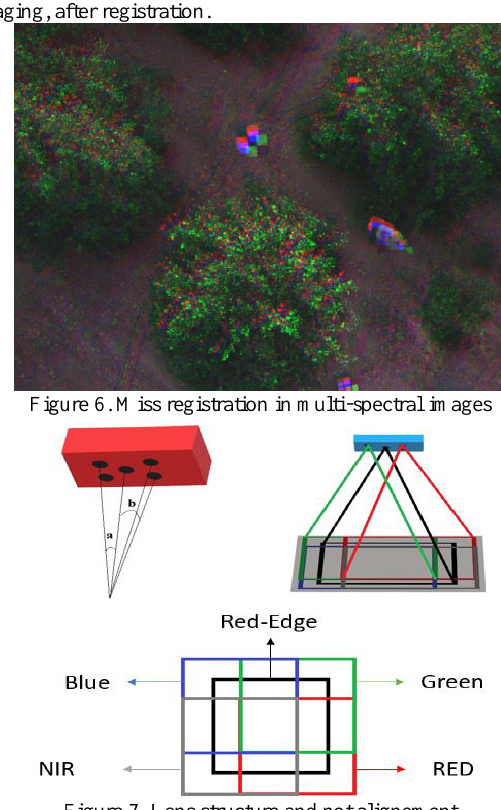
Figure 7. Lens structure and not